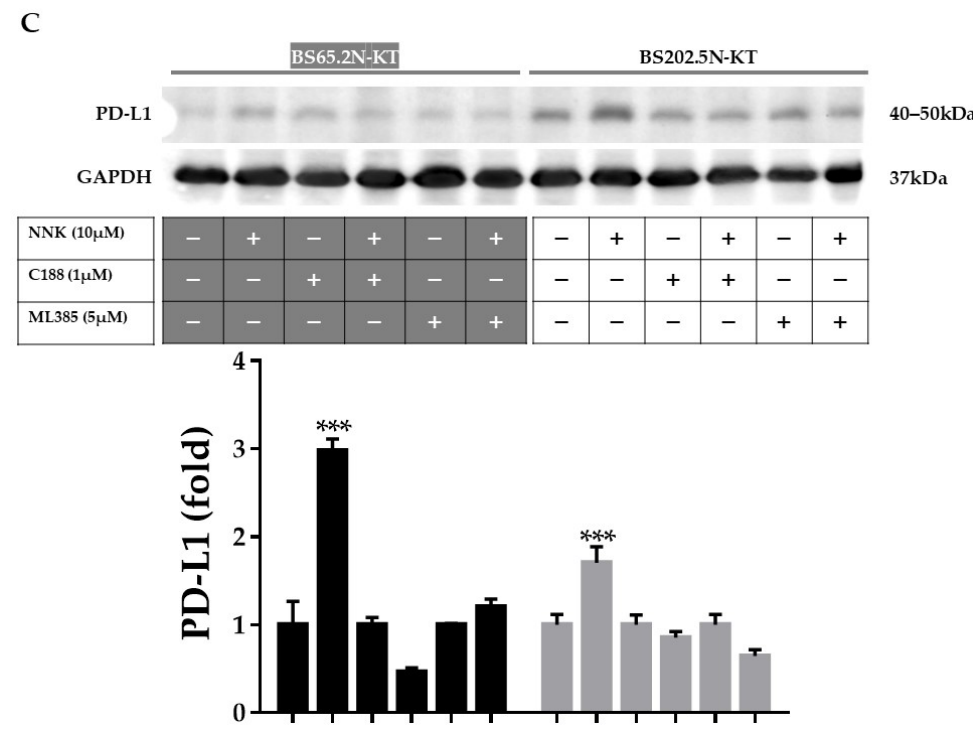
Figure 4. nAChR α 7-mediated NNK-induced PD-L1 expression through NRF2 and STAT3 signaling. ( A ) HBECs transfected with non-targeting or CHRNA7 -targeting siRNA (50nM) for 24 h were seeded on the assay plate of a Cignal 45-pathway reporter array and then reverse-transfected with reporter plasmids. Cells were then treated with NNK (10 μ M) for another 24 h. Firefly and Renilla luciferase activities were measured. Normalized luciferase activities were compared with those of non-NNK-treated cells. Representative pathways are shown. ( B ) HBECs were treated with non-targeting or CHRNA7 -targeting siRNA (50nM) for 24 h and then treated with NNK (10 μ M) for another 48 h. The expression of NRF2 and STAT3 phosphorylation was measured with Western blot analy- sis. ( C ) HBECs were co-treated with NNK (10 μ M) and the STAT3 inhibitor C188 (1 μ M) or the NRF2 inhibitor ML385 (5 μ M) for 48 h. PD-L1 protein expression levels were determined by Western blot analysis. The values are presented as mean ± S.D. from technical triplicate experiments. *** p < 0.001.